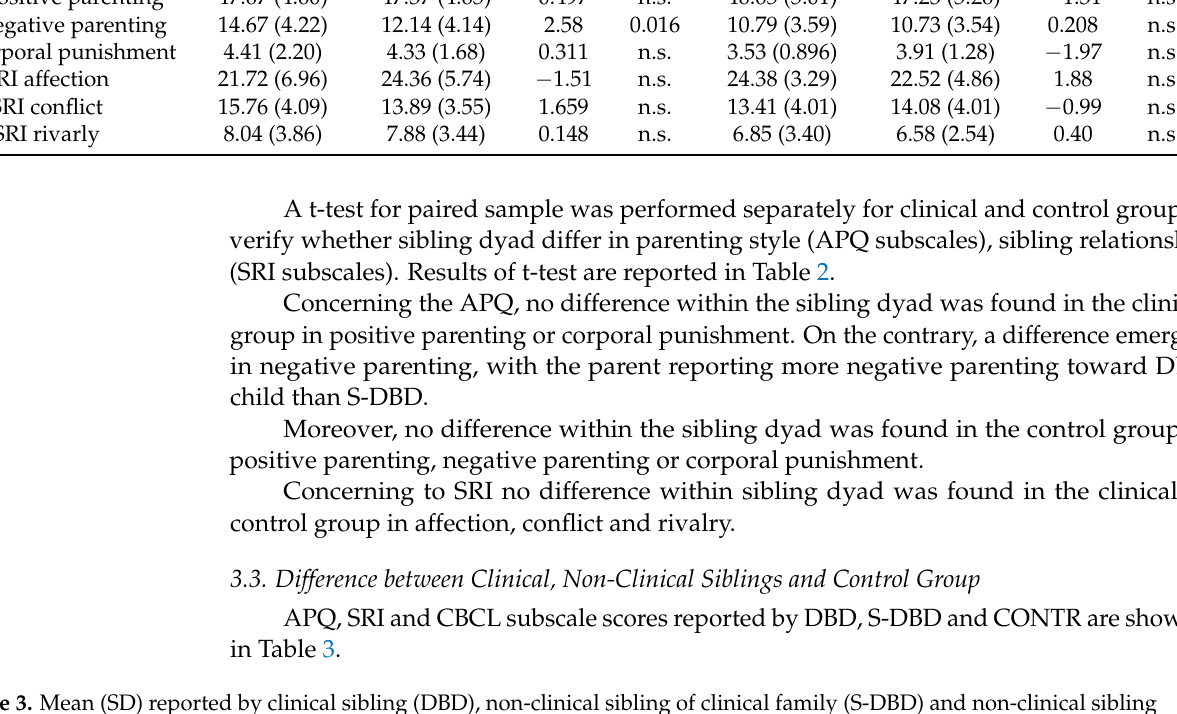
Table 3. Mean (SD) reported by clinical sibling (DBD), non-clinical sibling of clinical family (S-DBD) and non-clinical sibling of control group (CONTR) in APQ, SRI and CBCL subscales. Results of one-way ANCOVA are reported. DBD S-DBD CONTR